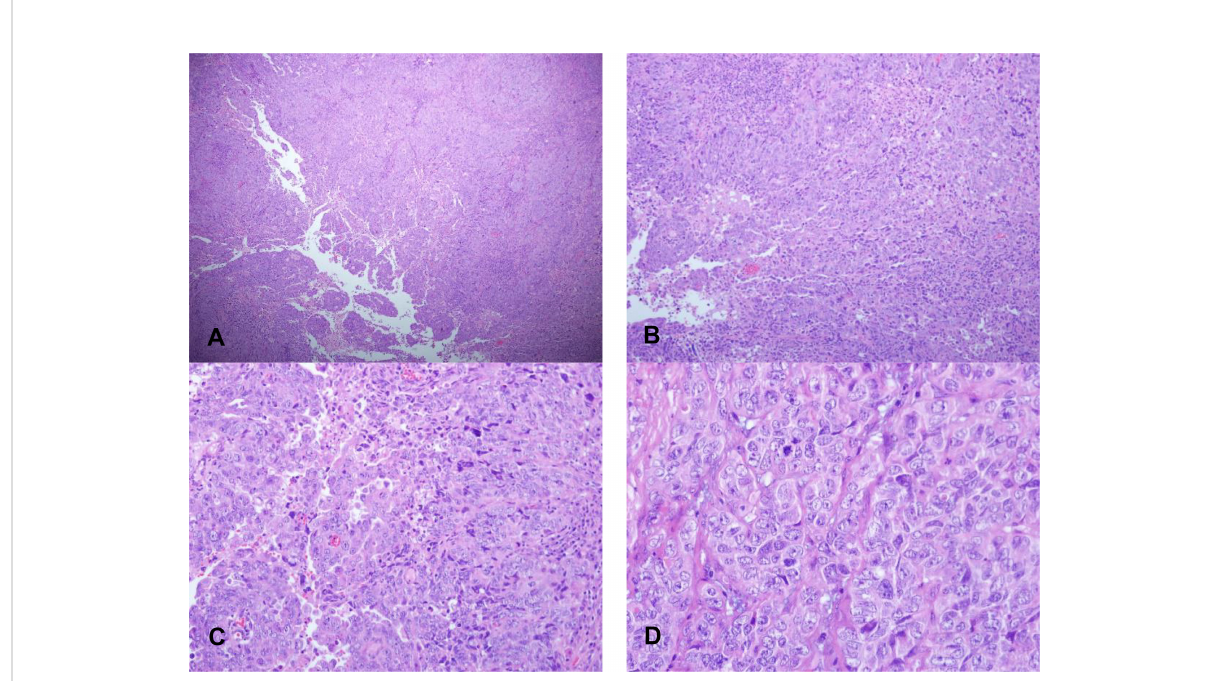
FIGURE 6 Morphological characteristics of EECs of TP53 subtypes. (A) X40 and (B) X100: The coexistence of solid and adenoid tumors of EECs of TP53 subtypes. (C) X200 and (D) X400: The contrast between nuclear atypia and tissue structure is slightly lower with mitotic